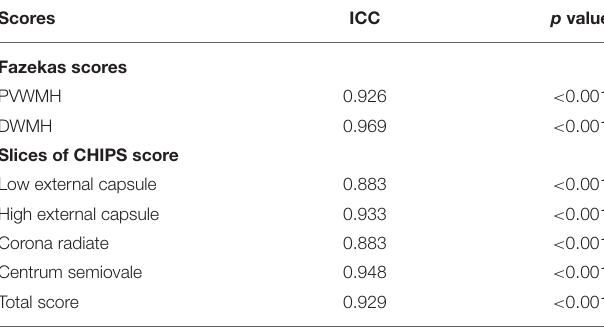
TABLE 1 | Inter-rater reliability of visual ratings.